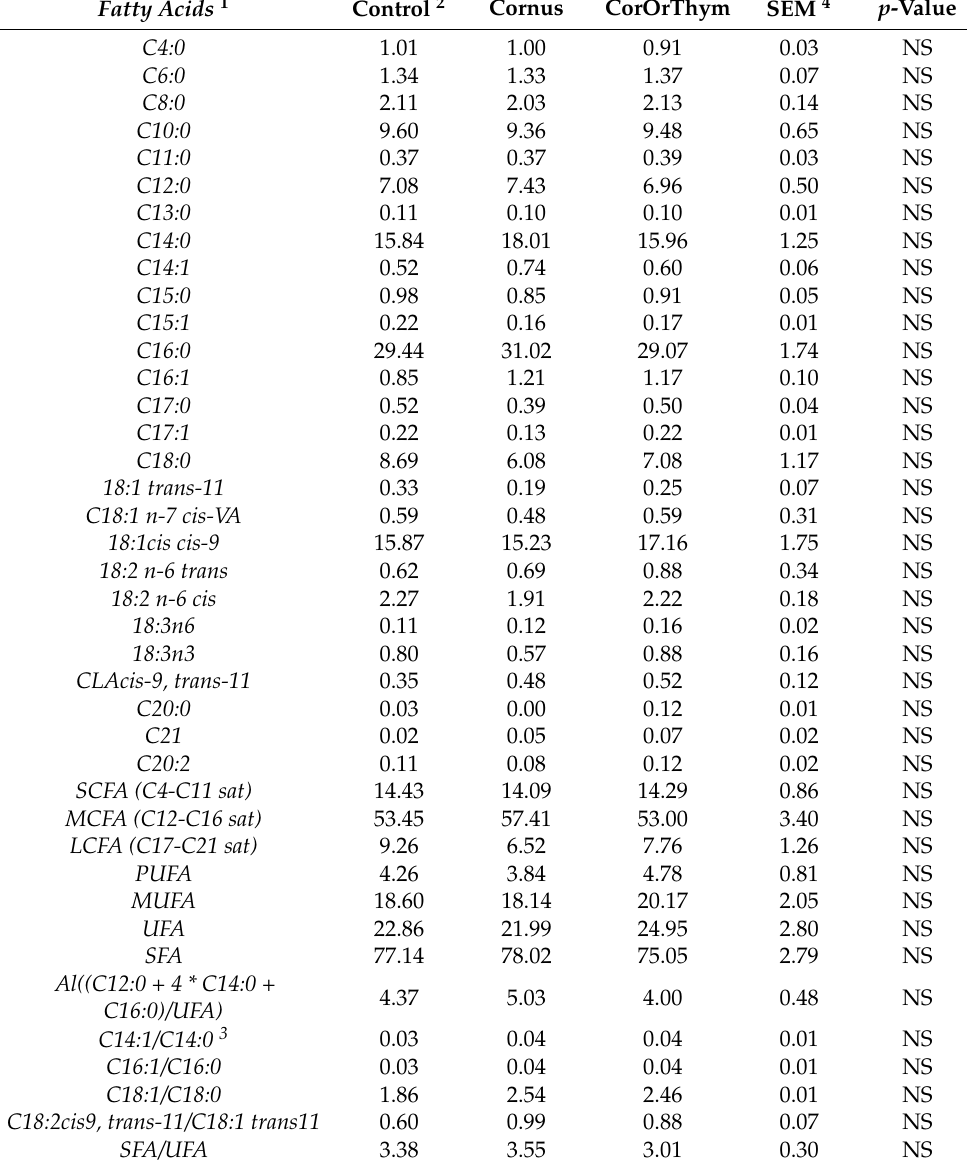
Table 7. Effects of diet supplementation with cornus extract and oregano and thyme essential oils on fatty acid profile of milk (% of total identified fatty acids).